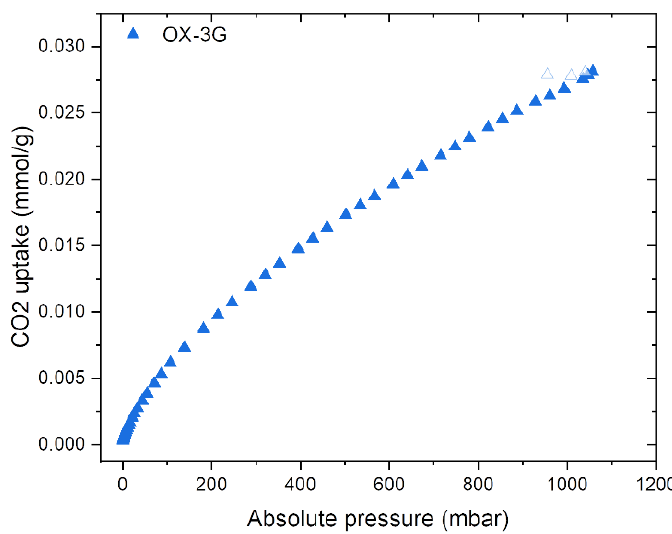
Figure 7. Gas sorption analysis with CO 2 at 0 °C for powder OX-3G sandstone sample from Pentalofos Formation as representative sample. Showing a potential for CO 2 storage within the relevant sandstone sample. Adsorption (solid symbols) and desorption (open